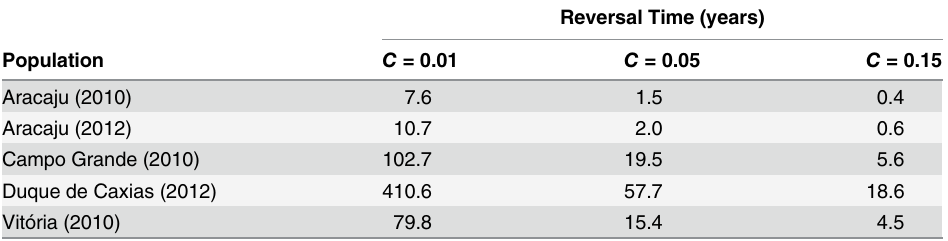
Table 3. Reversal times for field